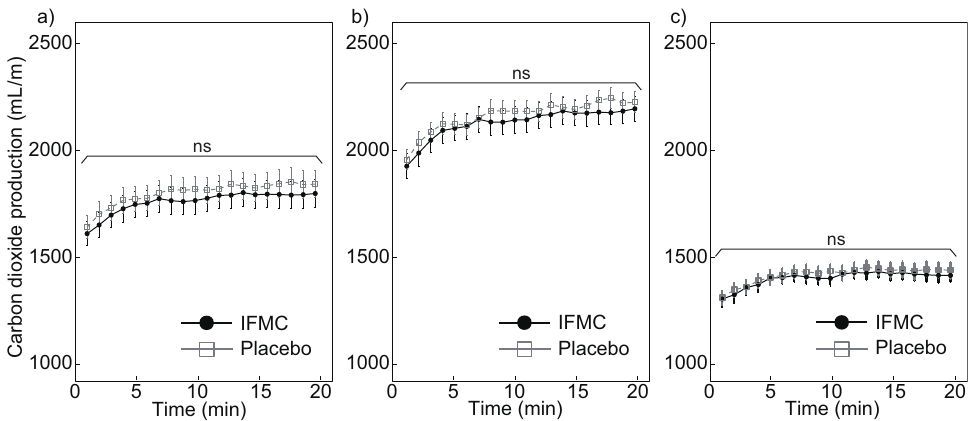
Figure 6. Differences in ( a ) all, ( b ) male, and ( c ) female CO 2 production over 20 min between IFMC and placebo applications. The “ns” stands for “not significant ( p >